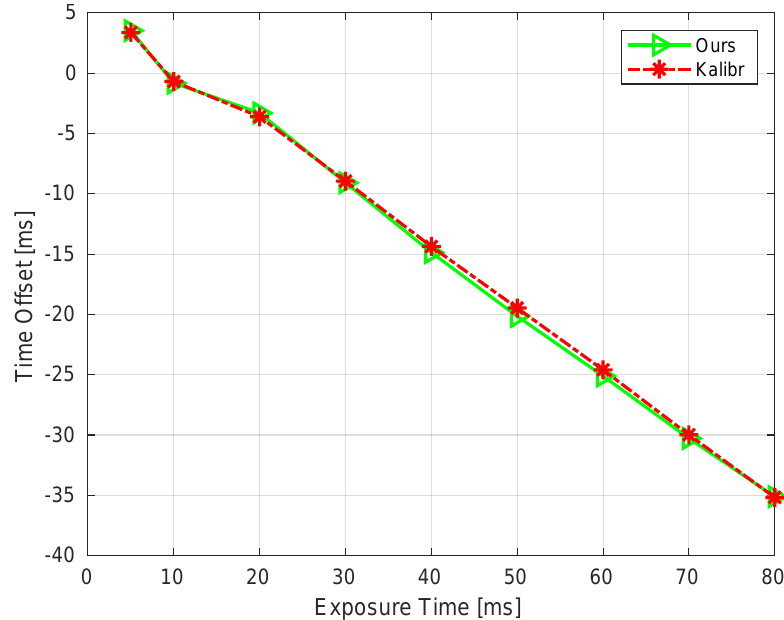
Figure 12. Calibrated time offsets under different exposure times of